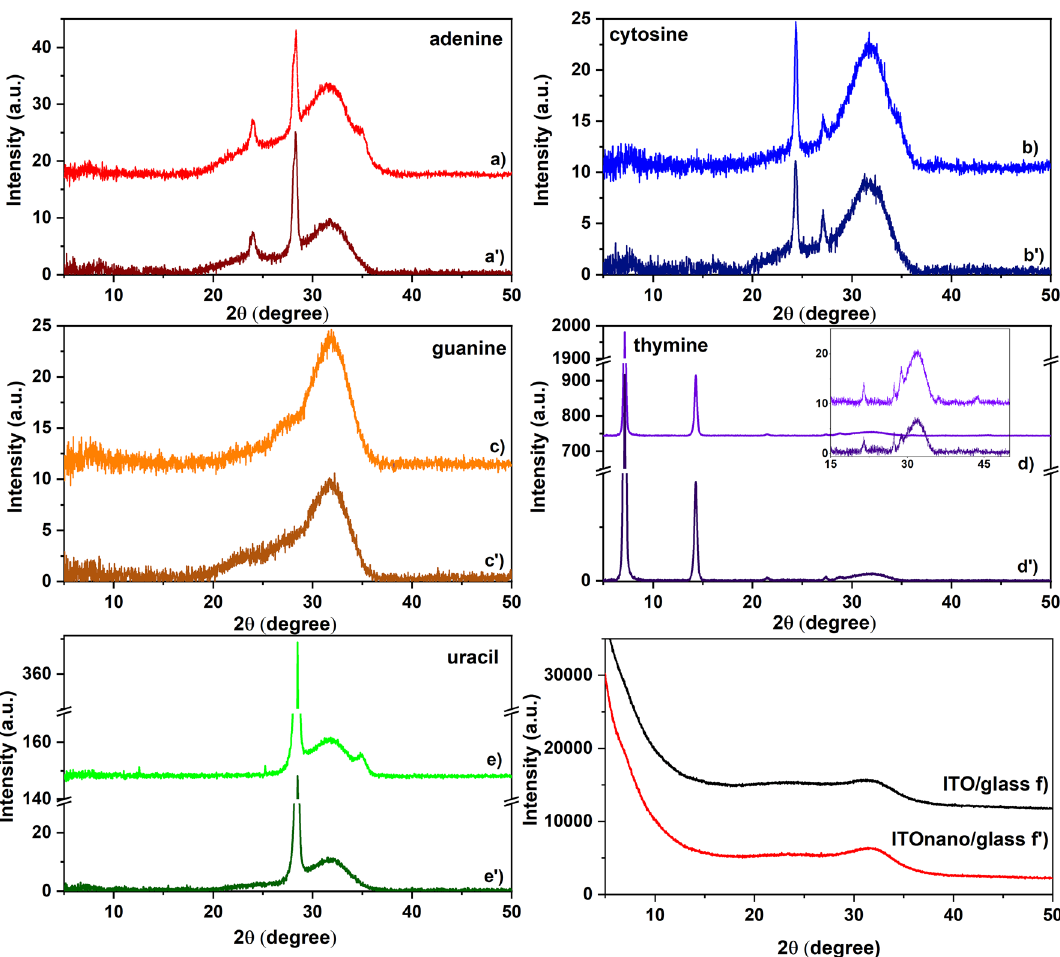
Figure 5. X-ray diffractograms of nucleobases thin films deposited by VTE: ( a ) adenine; ( b ) cytosine; ( c ) guanine; ( d ) thymine; ( e ) uracil on flat ITO/glass substrates and ( a’ ) adenine; ( b’ ); cytosine; ( c’ ) guanine; ( d’ ) thymine; ( e’ ) uracil on patterned ITO/glass substrates; ( f ) ITO/glass substrate; ( f’ ) patterned ITO/glass substrate. The inset in ( d ) shows details of the XRD pattern in the range